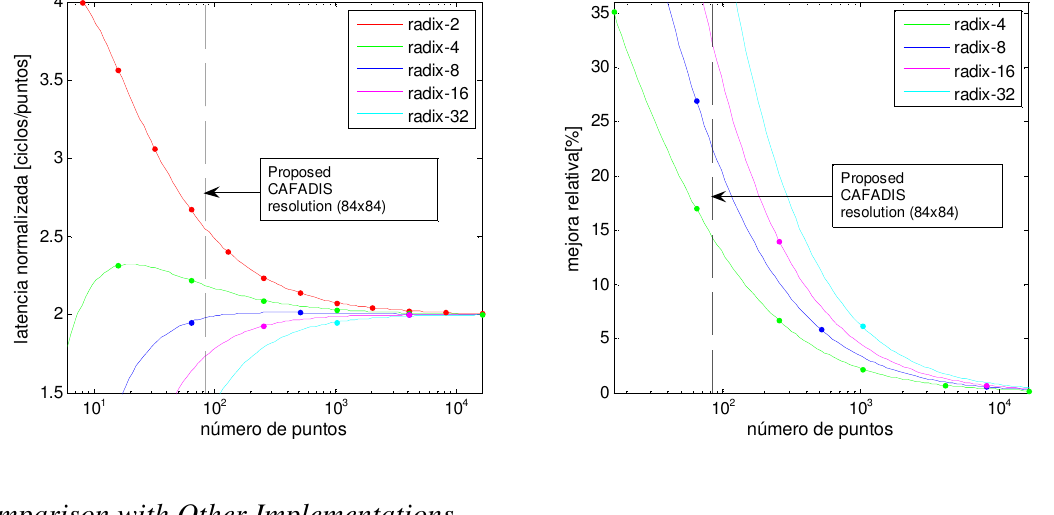
Figure 7. (a) Normalized latency. (b) Relative improvement regarding radix-2